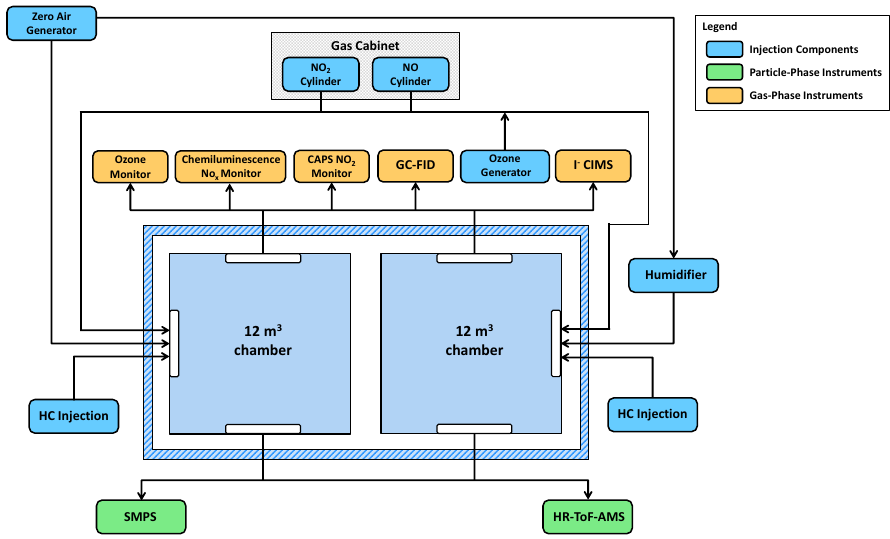
Figure 1. Schematic of the Georgia Tech Environmental Chamber (GTEC) facility.